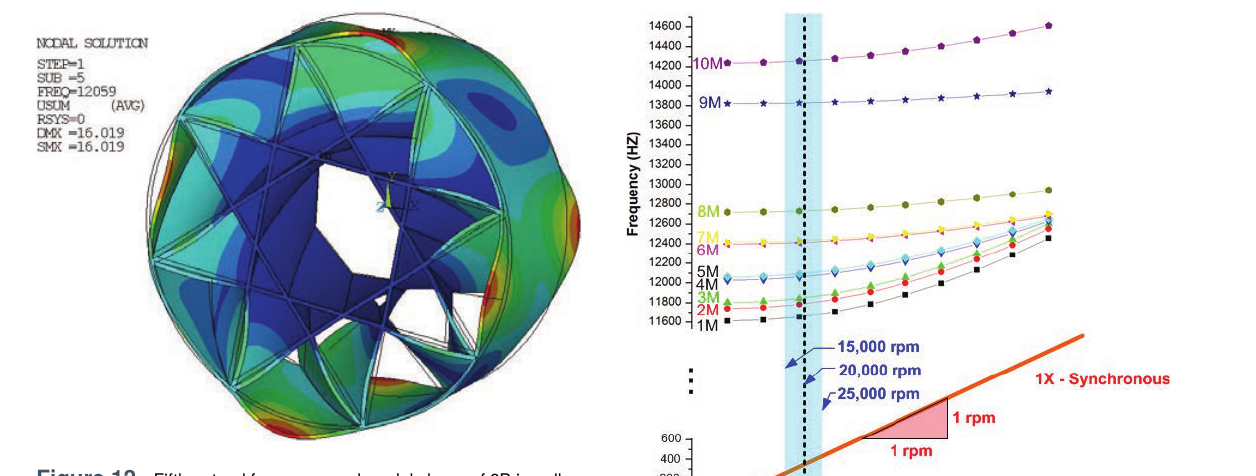
Fig.12.Fifth natural frequency and modal shape of 8B impeller Figure 12. Fifth natural frequency and modal shape of 8B impeller.